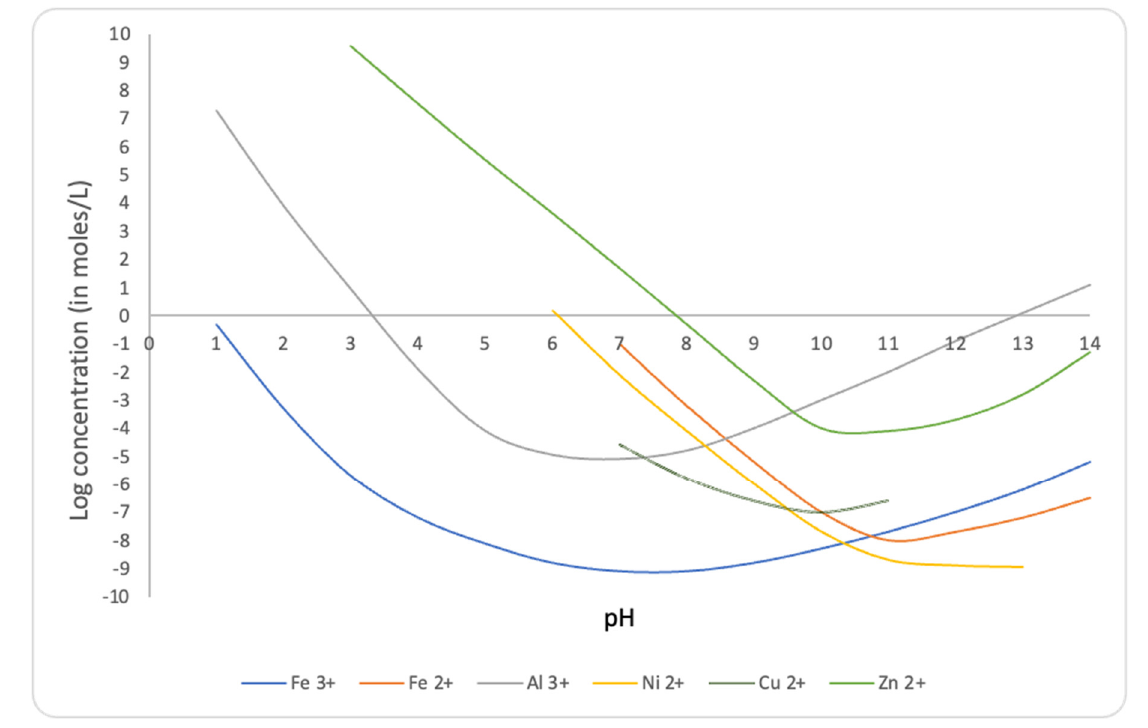
Figure 2. Solubilities of some metal hydroxides as a function of pH. Our calculations based on data from [6–11].